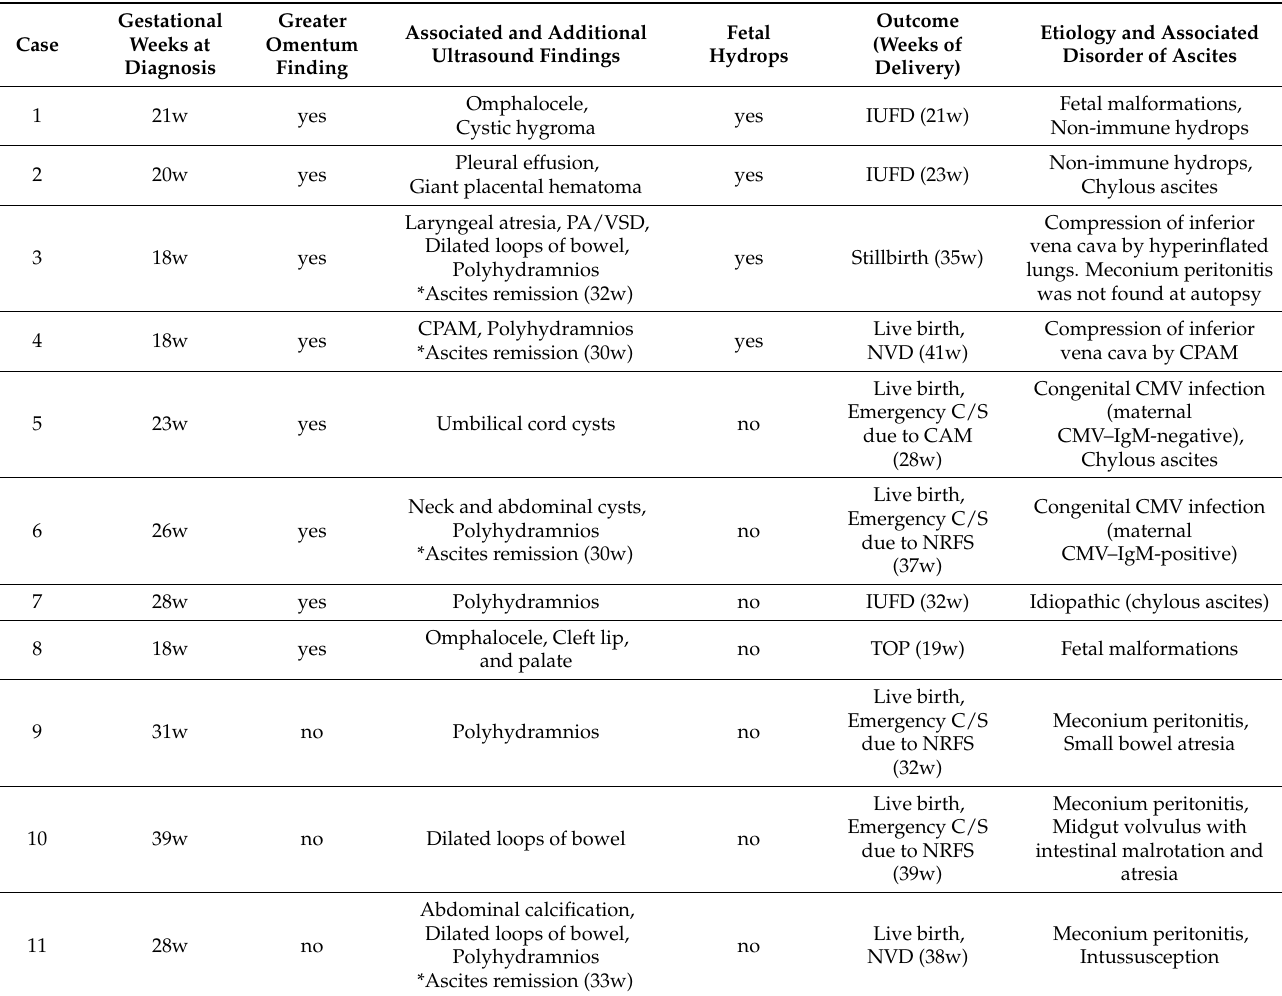
Table 1. Summary of 11 cases of fetal